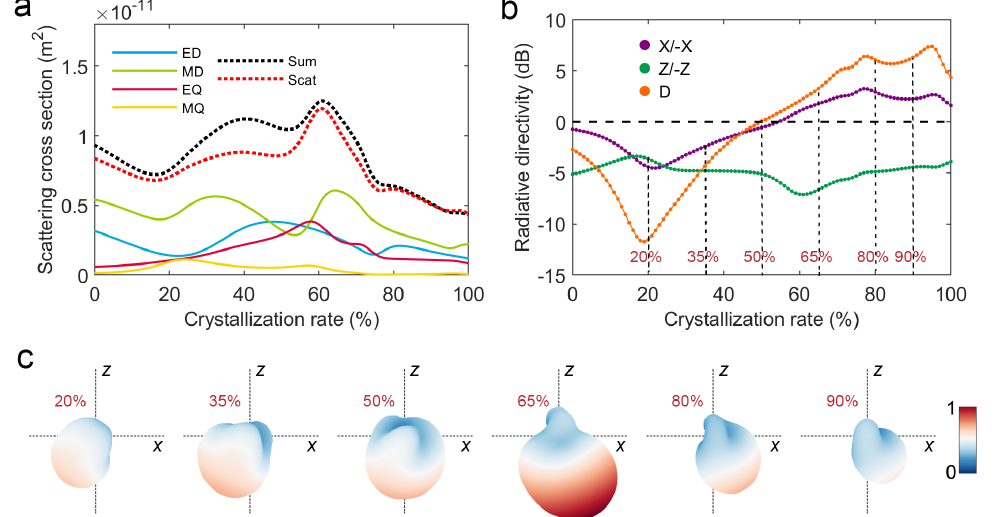
Figure 3. Scattering characteristics of V-shaped phase-change antenna at 3.6 µ m wavelength: ( a ) Con- tinuous changes of multipole scattering cross sections with the crystallinity; ( b ) Continuous changes of X/–X directivity, Z/–Z directivity, and D directivity with the crystallinity; ( c ) Modulus normalized far-field radiation patterns in crystallinity of 20%, 35%, 50%, 65%, 80%, and 90%, respectively.